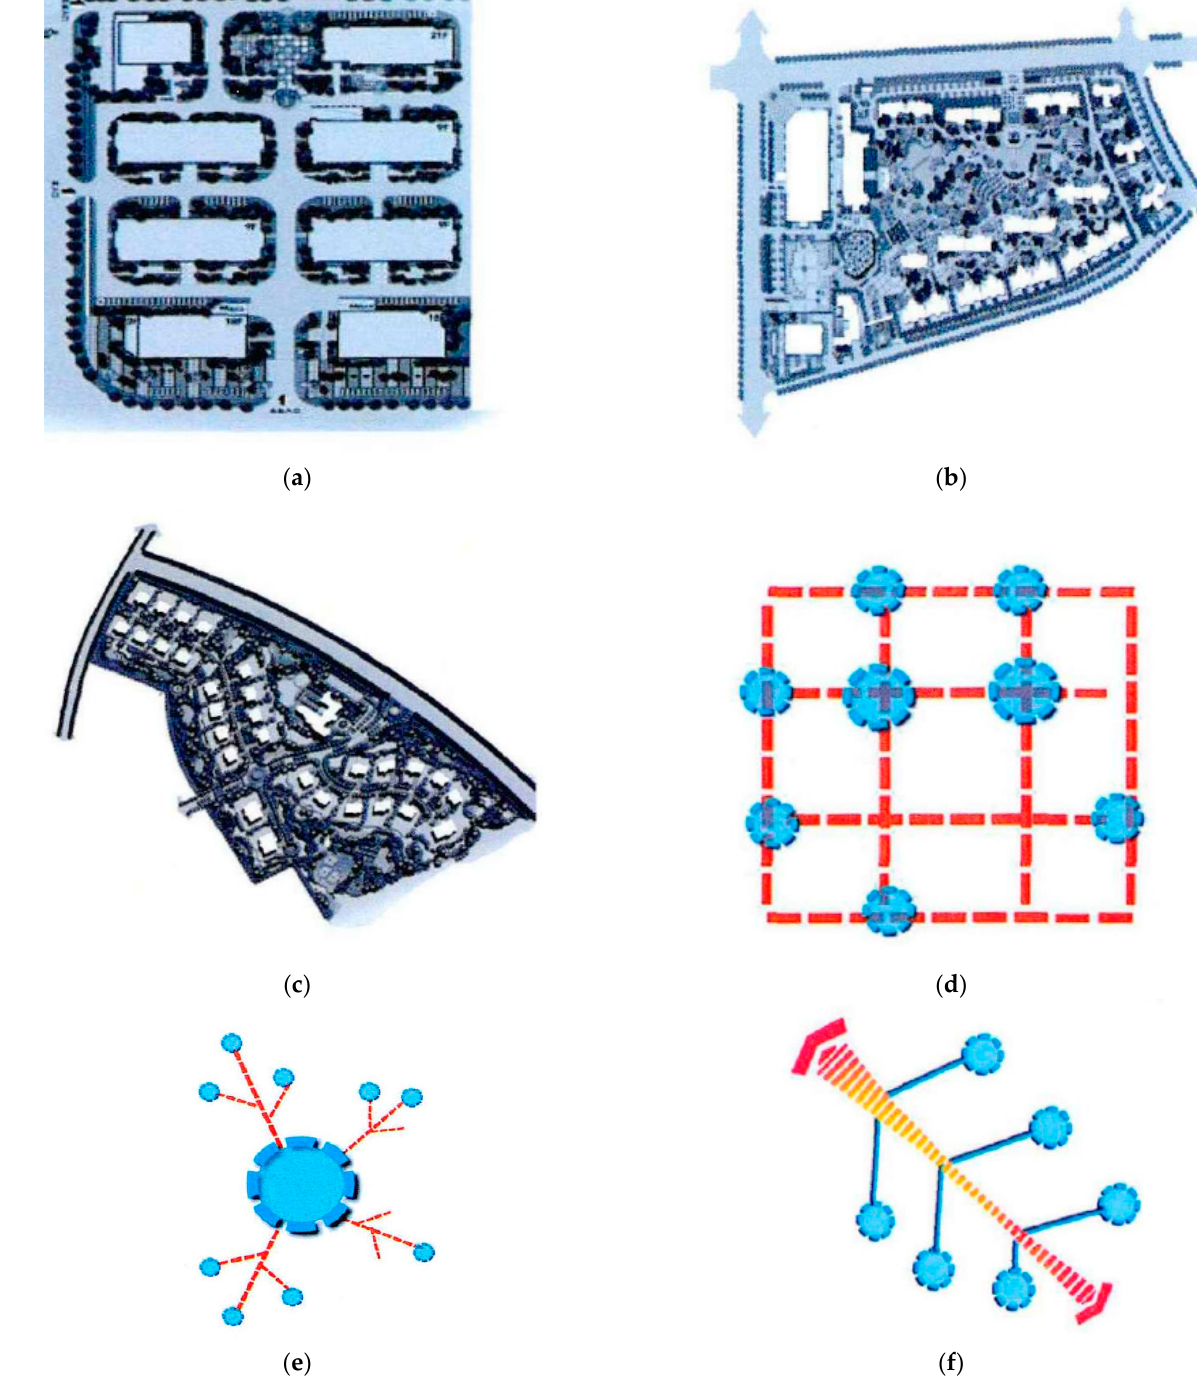
Figure 3. Main layout mode and rainwater collection mode of Tianjin residential area: ( a ) Block mode; ( b ) enclosed mode; ( c ) axial mode; ( d ) rainwater collection mode in URAs of block mode; ( e ) rainwater collection mode in URAs of enclosed mode; ( f ) rainwater collection mode in URAs of axial mode.